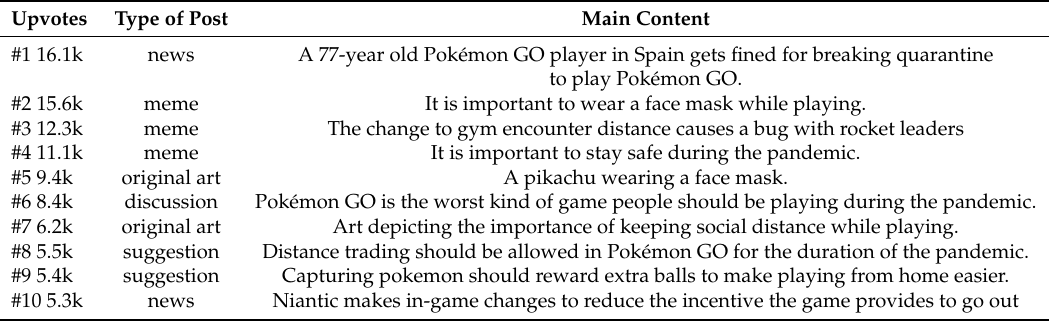
Table 4. TOP 10 most upvoted COVID related posts on /r/pokemongo during 4 March–3 April